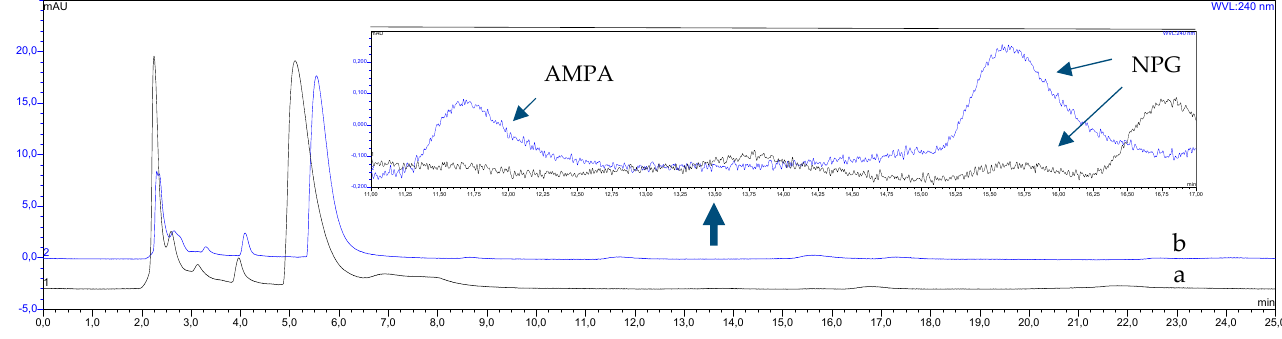
Figure 5. Chromatograms obtained from the analysis of UAE—SLM extracts of barley groats samples: (a)—blank sample and (b)—fortified extract (SLM conditions—donor: 100 mL of extract at pH = 11, acceptor: 5 mL 2 M NaCl, membrane phase: 20% Aliquat 336 in DHE, flow rate of donor and acceptor phases: 0.2 mL/min, extraction time: 24 h). According to the analysis of Glyphosate residues in foods from the Canadian Retail Markets between 2015 and 2017 [18], the maximum observed concentration of glyphosate was 0.45 ppm, which is almost 10 times below the MRL of 3 ppm. For lentils the level of the determined NPG was between 0.021–2.6 ppm. In barley it was 0.098 ppm, whereas dried soybeans contain 0.0069–0.024 ppm of NPG. For buckwheat (grain) it was 0.006 - 0.33 ppm and rice (flour) 0.007-0.034 ppm. As it can be seen the developed method make possible the determination of NPG and AMPA at requiered level. 4. Conclusions Glyphosate is among the universally used pesticides in the world. Glyphosate is currently still authorized for use in both Germany and the European Union (EU) as a plant protector substance for the combating of weed. There is a tendency towards more frequent determinations of glyphosate in certain food groups, including lentils, linseeds, buckwheat and millet in the cereals and cereal products category, as well as in legumes. According to the U.S. Food and Drug Administration (FDA) Pesticide Residue Monitoring Report from 2018 glyphosate was determined in over 60% of corn samples, and 67% of soybean samples. A high frequency of detection can be seen here in buckwheat (15%). From a total of 473 samples from the category legumes, oil seeds, nuts, and soy products, 40 samples (9%) were positive for glyphosate in amounts > 0.02 mg/kg. Exceedances of the MRLs occurred in 15 samples (about 3%). A high frequency of NPG findings was observed in peanuts (13%), chick peas (11%), linseeds (21%) and lentils (15%), walnuts